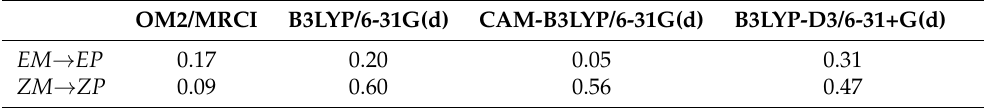
Table 1. Energy barriers from EM to EP isomers and from ZM to ZP isomers in the ground state, obtained from the OM2/MRCI, B3LYP/6-31G(d), CAM-B3LYP/6-31G(d), and B3LYP-D3/6-31+G(d) methods. The energy unit is